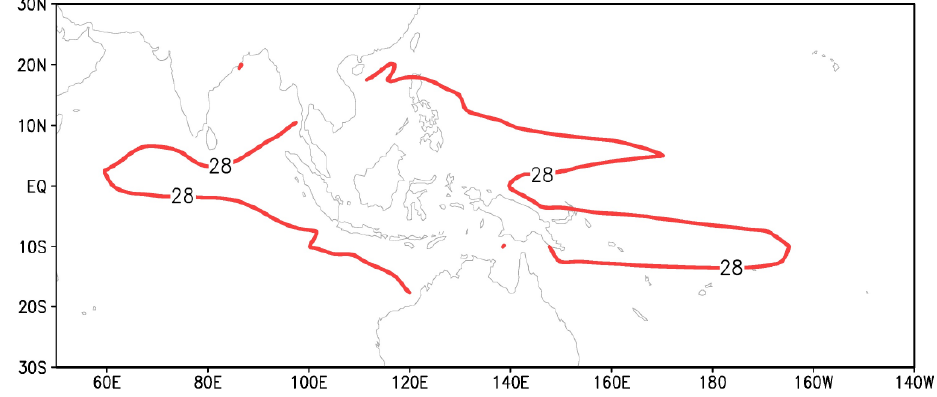
Figure 1. Area of the Indo-Pacific warm pool surrounded by 28 ◦ C isotherm line. Annual mean SST values are provided by the HadCM3 simulation for MIS-13 (Muri et al.,